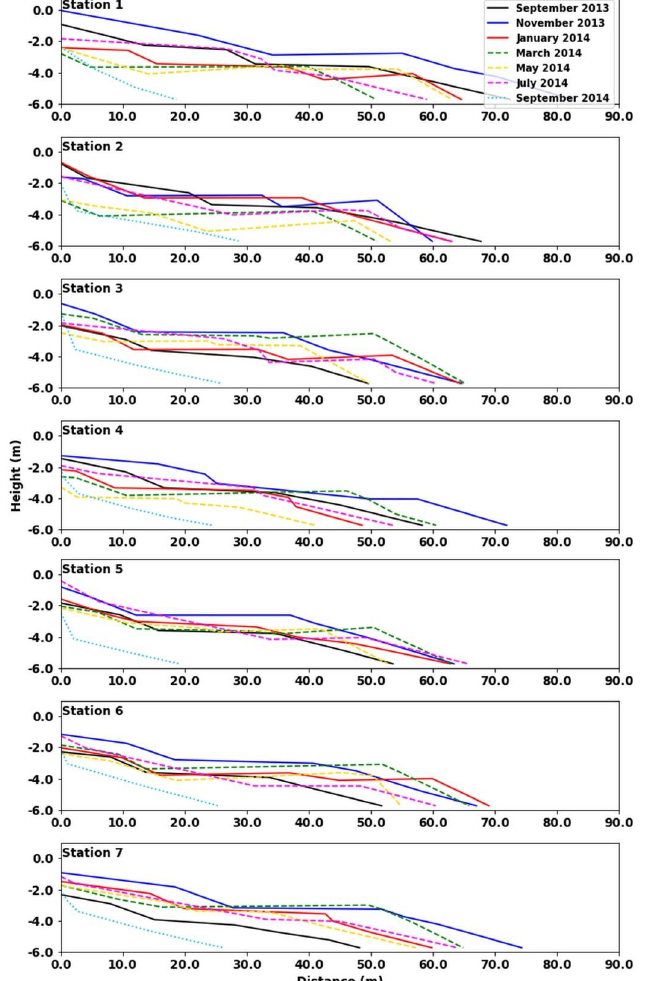
Figure 2. Beach profiles recorded at sampling stations from September 2013 – September 2014. For more information about the energy beach profile classification, see Table 1 and the Appendix A. Table 1. Energy beach profile classification: high (H), middle (M), and low